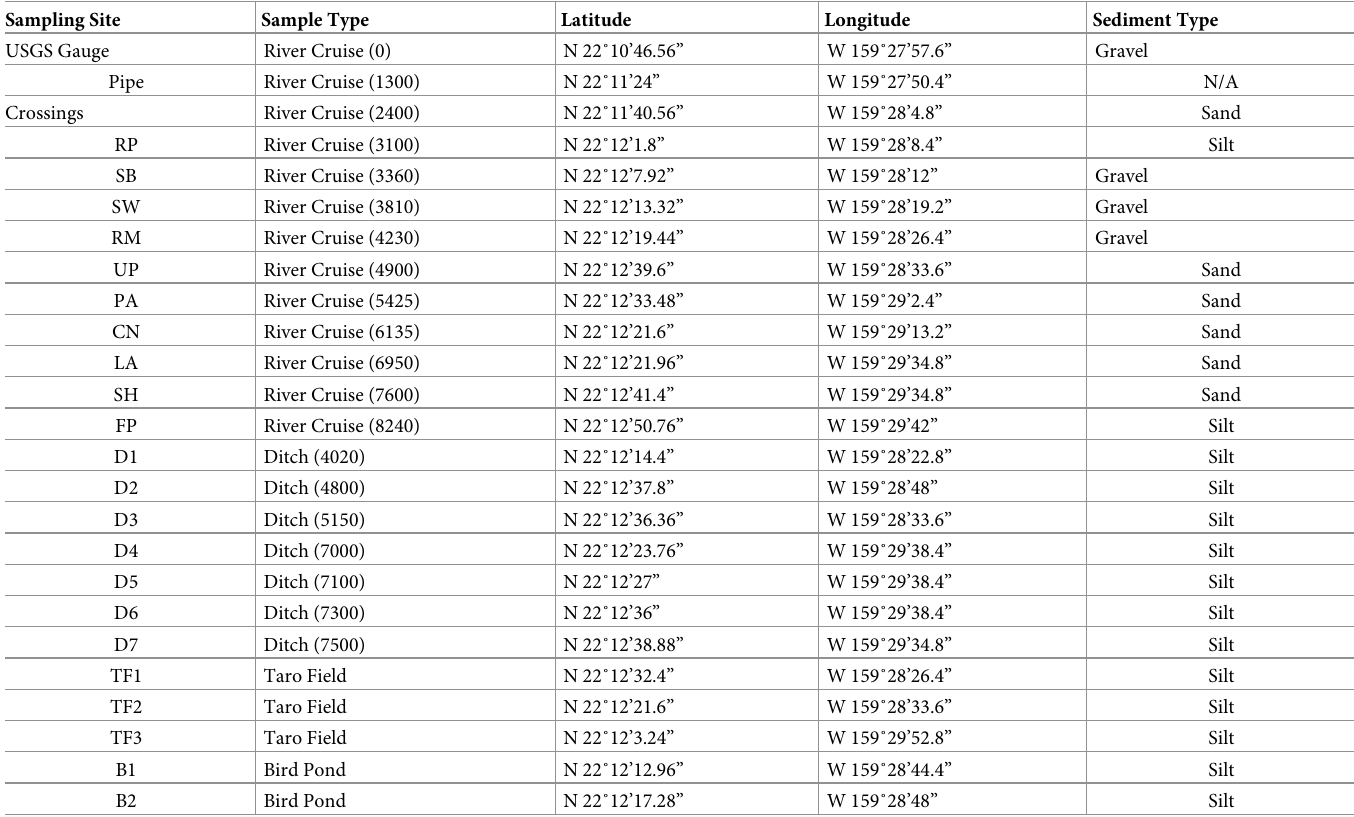
Table 1. Study sampling locations. Sampling sites denoted by sample type and corresponding GPS coordinates and sediment types. Distances (meters) from the USGS gauge is provided next to the sample type. Sampling